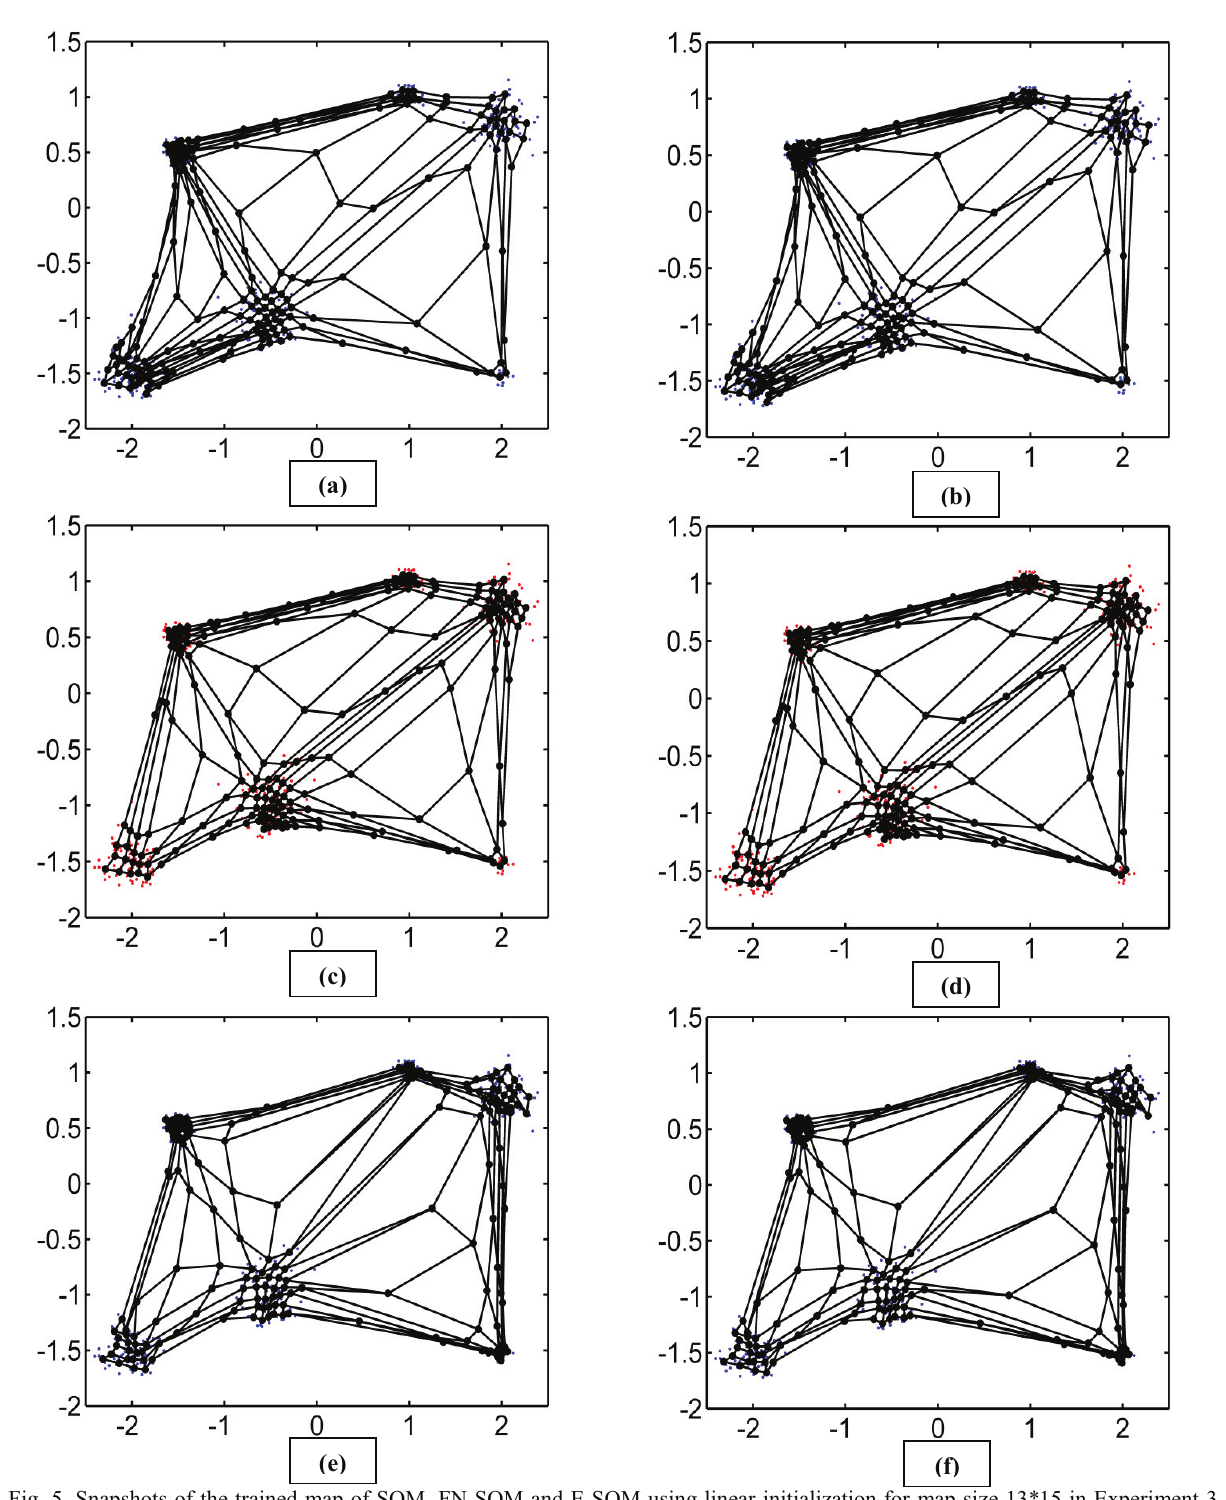
Fig. 5. Snapshots of the trained map of SOM, FN-SOM and E-SOM using linear initialization for map size 13*15 in Experiment 3. (a) Conventional SOM (ten epochs) (b) Conventional SOM (twenty epochs) (c) FN-SOM (ten epochs) (d) FN-SOM (twenty epochs) (e) E-SOM (ten epochs) (f) E-SOM (twenty